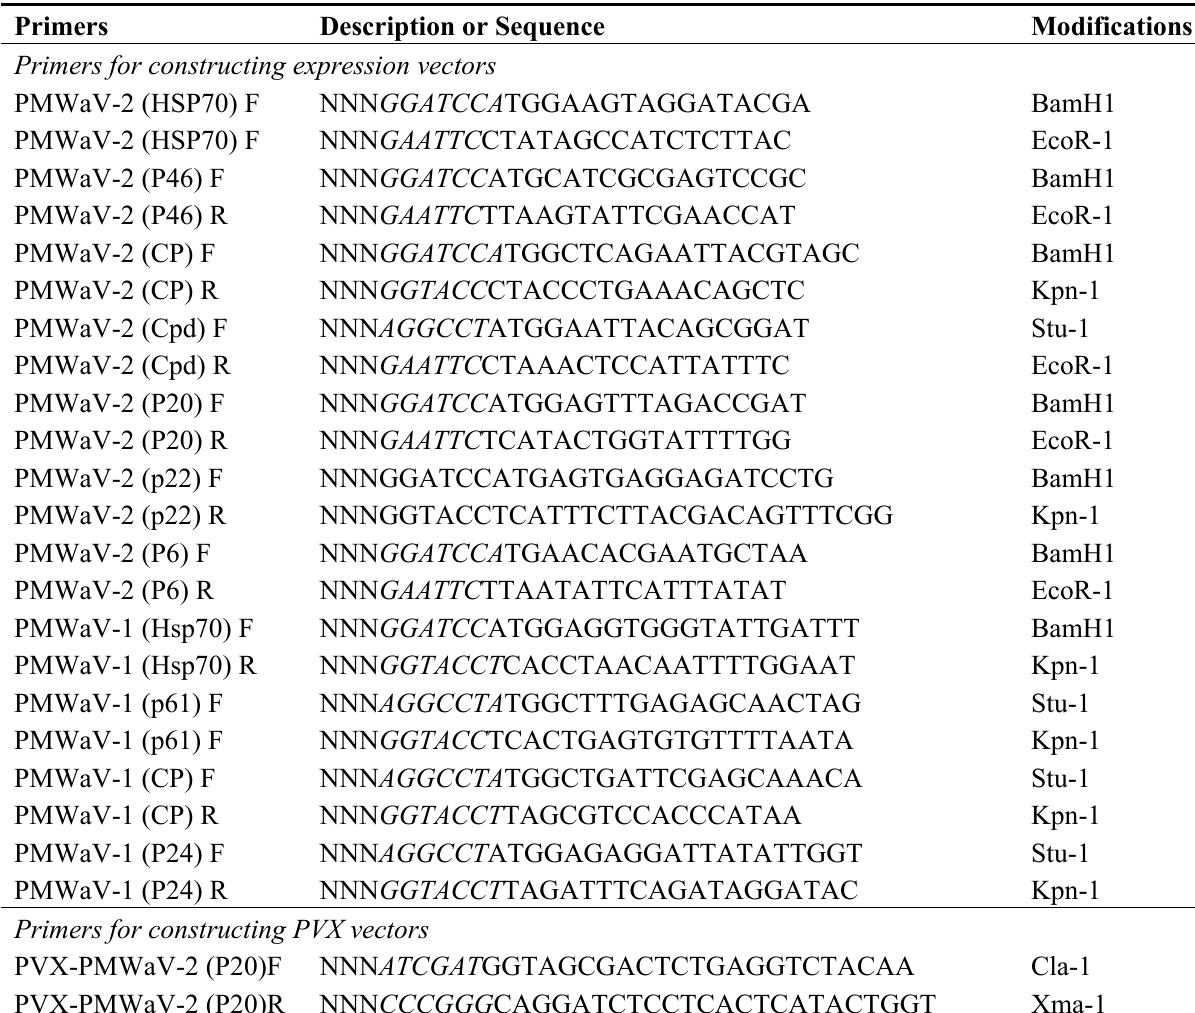
Table 1. Primers used for PCR amplification of PMWaVs ORFs used to make expression constructs and to clone genes to produce Dig-labeled in vitro transcripts for Northern blot analyses. Random bases designated N (either A, T, G, or C) are included at the 5’-end of primers to increase the efficiency of restriction